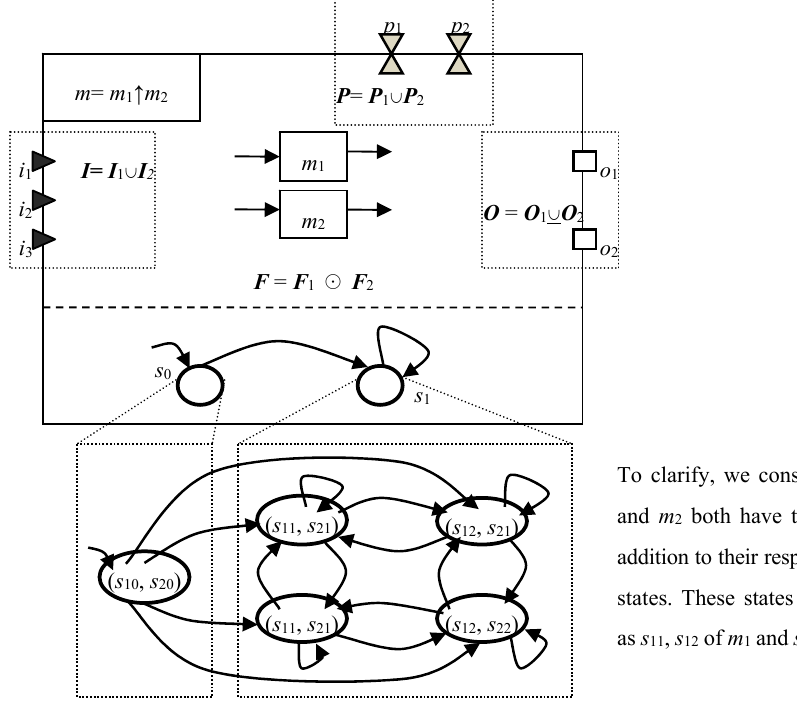
Figure 6. The diagram definition of the Parallel operator.